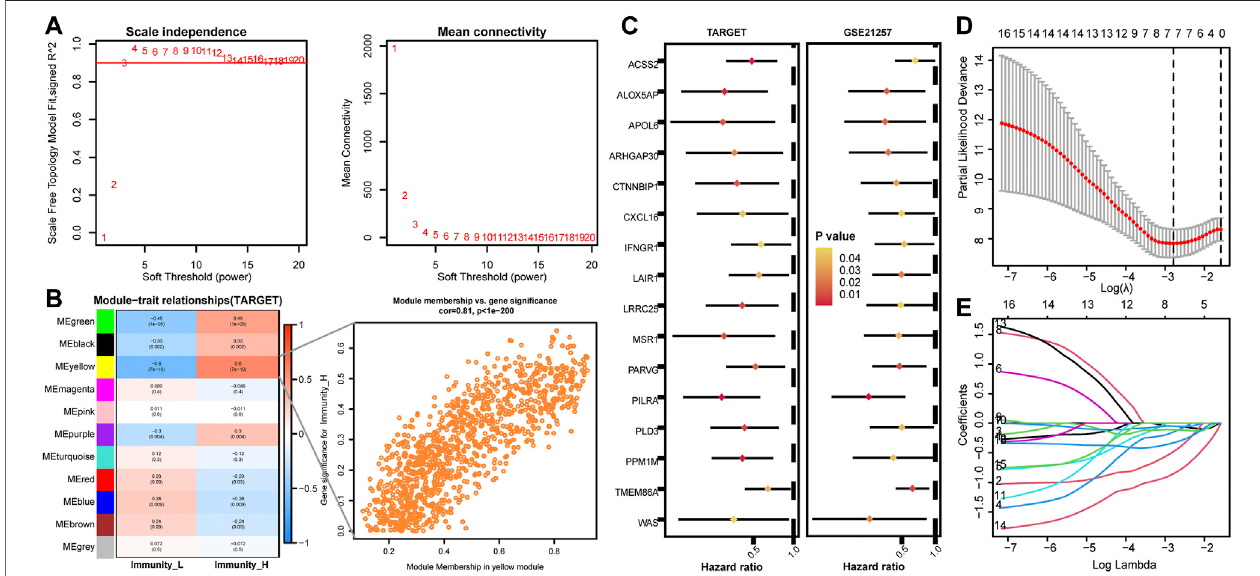
FIGURE 2 | Identi fi cation of key modules by WGCNA in the TARGET cohort and establishment of IRPS by LASSO regression analysis. (A) Identi fi cation of power value. When the power value is 3, the red line represents R 2 > 0.9. (B) Heat map of the correlation between gene modules and immune subtypes. The value of each cell represents the correlation coef fi cient. The value of parentheses is the p value. The fi gure on the right shows a scatter plot of the relationship between gene signi fi cance and module membership in the yellow module. (C) Univariate Cox regression analysis of prognostic genes in TARGET and GSE21257 cohorts. (D,E) Lasso Cox regression analysis identi fi ed 7 genes as candidates for IRPS